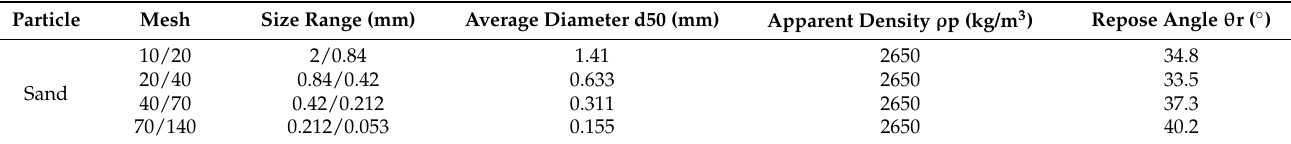
Figure 1. Experimental procedures and instruments. Table 1. Particle parameters used in experiments.